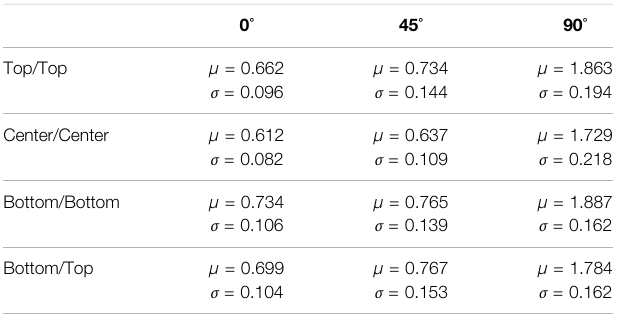
TABLE 1 | Summary ofage ofairstatisticsforventilation con fi gurations withawall porosity of 5%. 0 ° 45 °